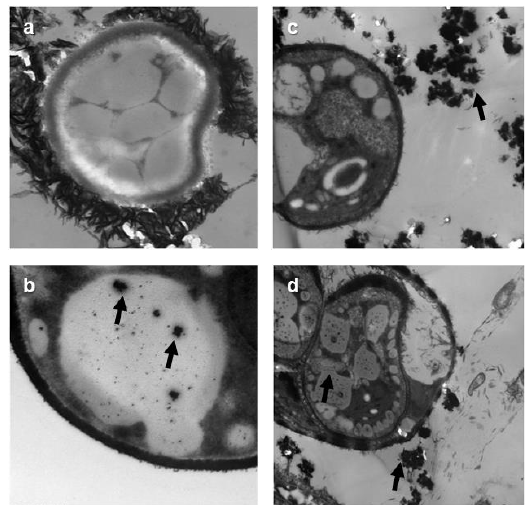
Figure 6. Transmission Electron Microscopy (TEM images for cells exposed to different concentration of Ag NPs. ( a ) control; ( b ) 50 nm, 200 mg L −1 ; ( c , d ) 100 nm, 200 mg L −1 (Arrows indicate the aggregates of Ag NPs in the culture medium and inside cells).